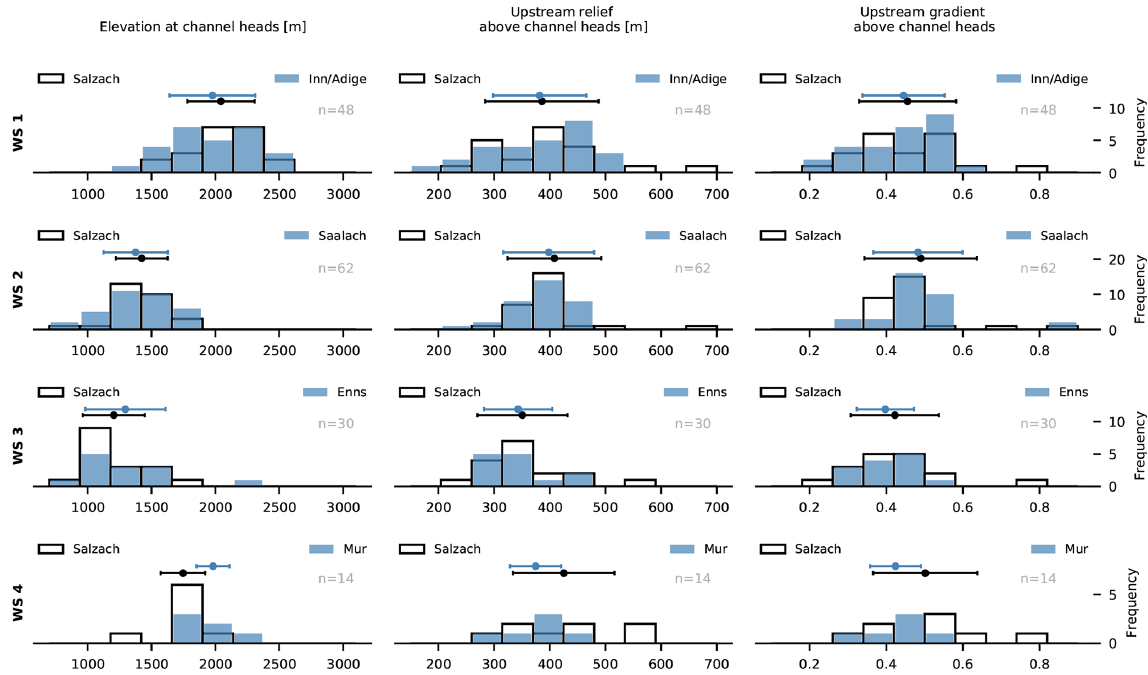
Figure 5. Gilbert metric histograms (Forte and Whipple, 2018) for the investigated watersheds of the study area. Histograms with a blue filling represent the adjacent Inn–Adige (WS 1), Saalach (WS 2), Enns (WS 3) and Mur (WS 4) drainage basins with n as the total number of data points. Data are divided into 10 equally spaced bins. Error bars indicate the standard deviation, and filled circles are the mean values of the